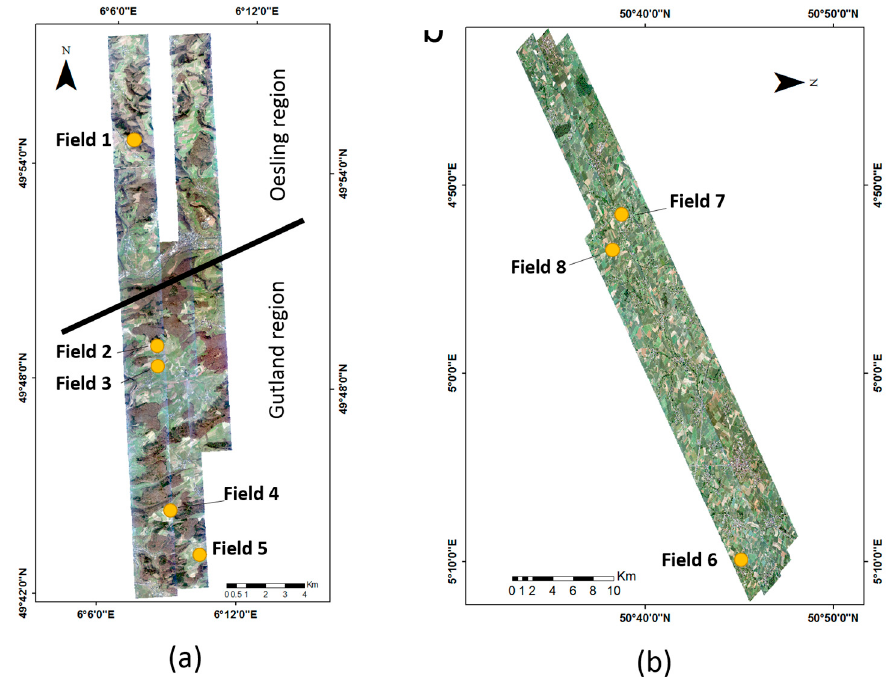
Figure 3. RGB (red: 661 nm; green: 545 nm; blue: 450 nm) airborne images acquired by APEX sensor in Luxembourg ( a ), and Belgium ( b ), and the location of the eight validation fields.